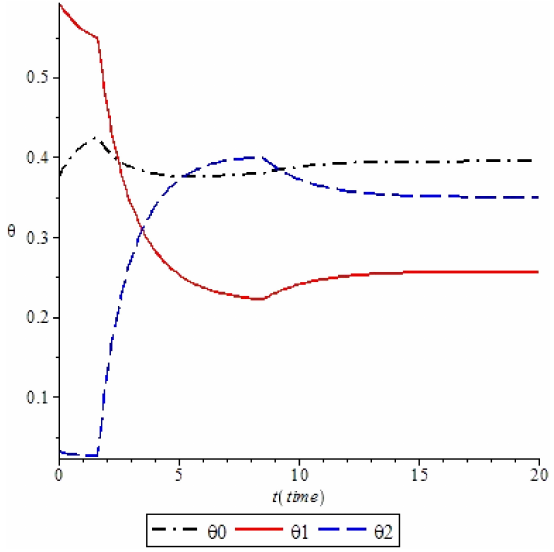
Fig. 8. Graphs of the optimal distribution of labor